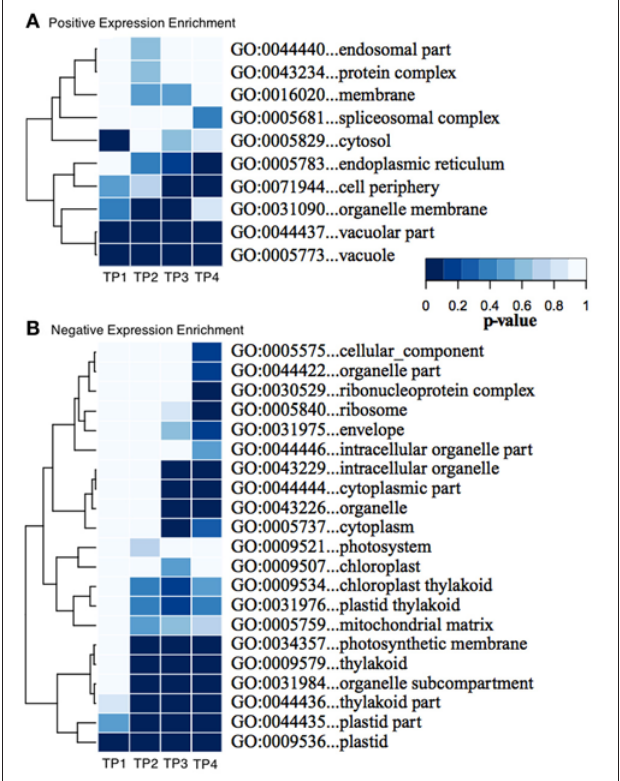
FIGURE 1 | (A,B) Enrichment of GO “Cellular Component” categories across the time series of winter hardening. The GO tool Ontologizer was used to assess statistical enrichment of genes related to the cellular component ontology. Only GO terms with significant enrichment for at least one time point are shown. Colors correspond to probability values for individual